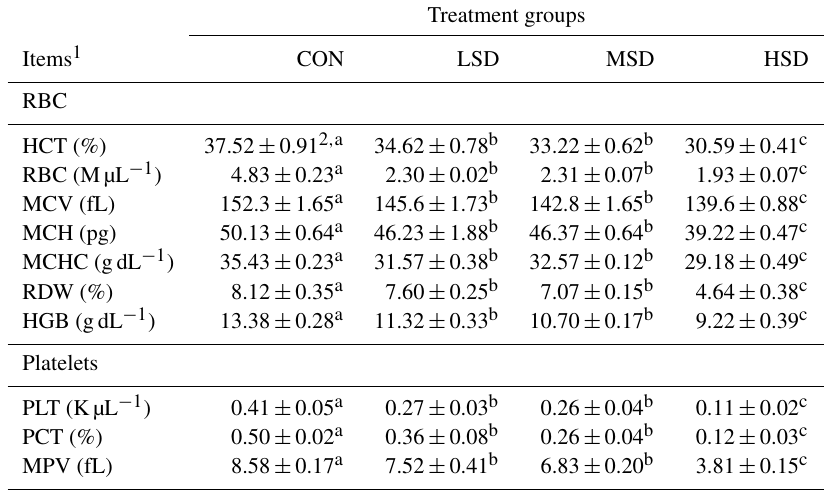
Treatment groups